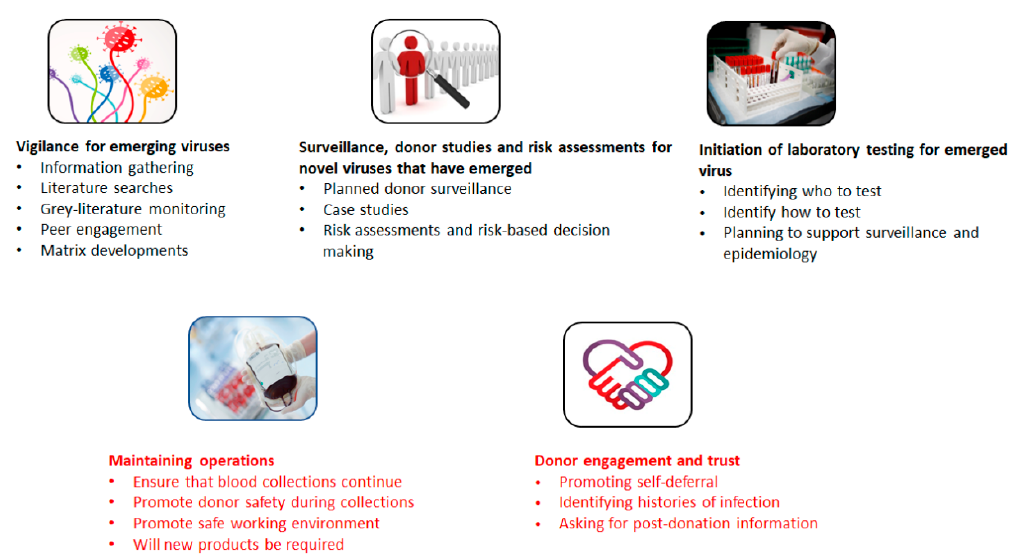
Figure 1. Four steps in a pandemic planning MFI. Pandemic planning is not a static process and required clear aims with well-designed proposed changes in practice. Effective pandemic planning also requires an understanding of how to measure implemented changes. PDSA cycles allow for incremental tests of change.